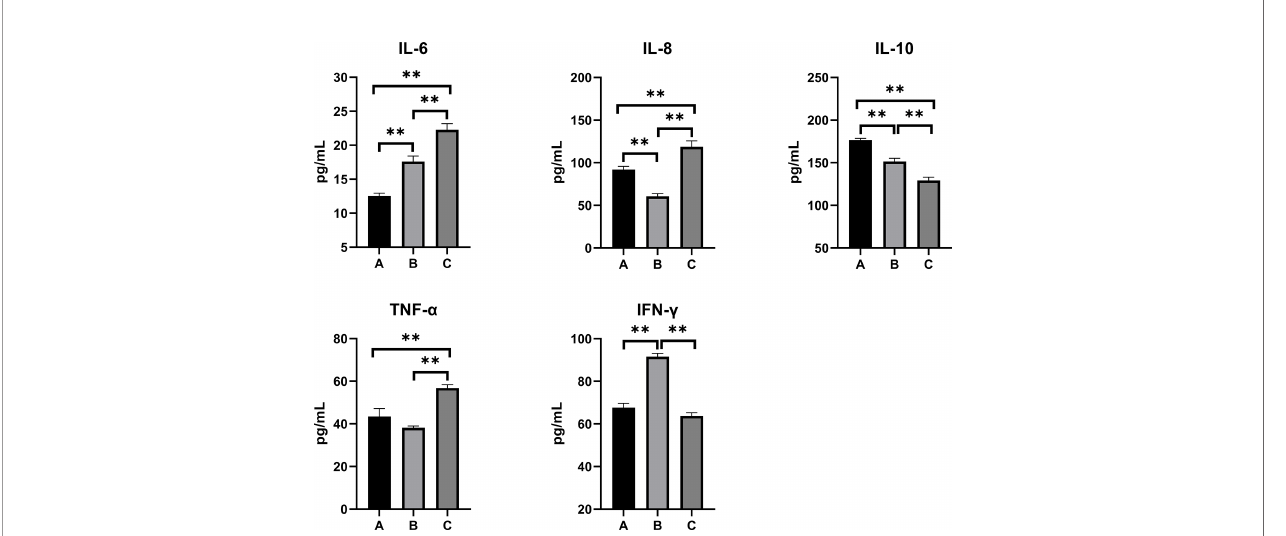
FIGURE 5 | Effects of OTA and AFB1 on serum cytokines (IL-6, IL-8, IL-10, TNF- a , and IFN- g ) of pullets after 42 days (n = 6, mean ± SEM). Groups A, B, and C are the control group, the pair-feeding group, and the OTA+AFB1 group, respectively. Data were analyzed with ANOVA and Tukey ’ s HSD, and signi fi cant differences